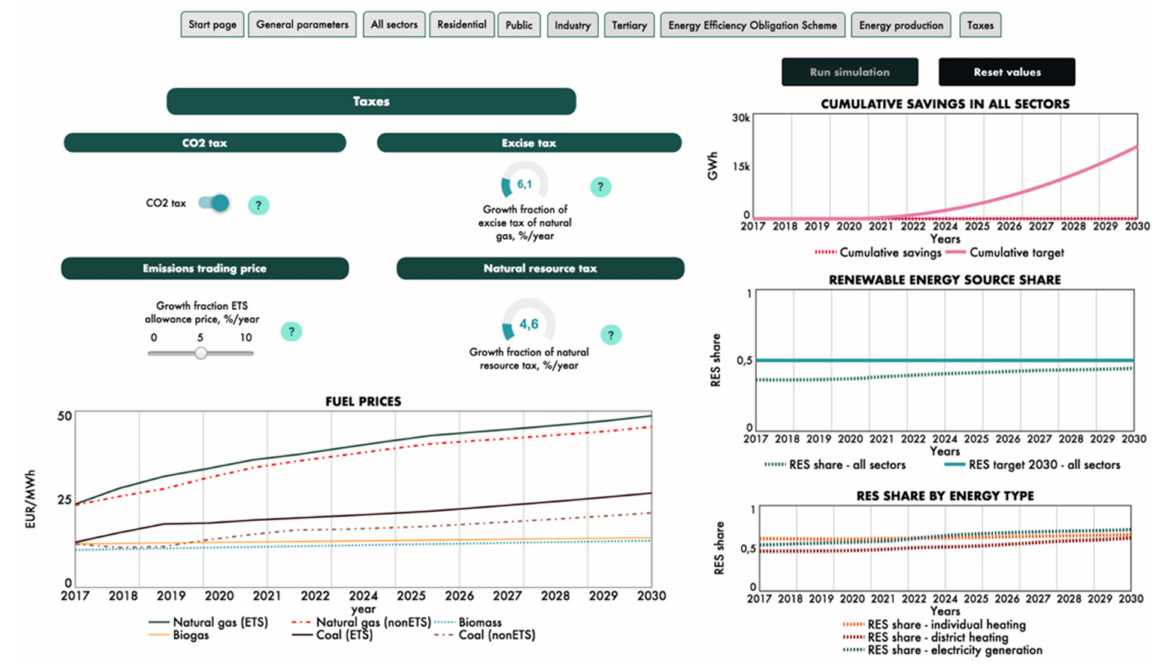
Figure A9. Internet-based model interface for